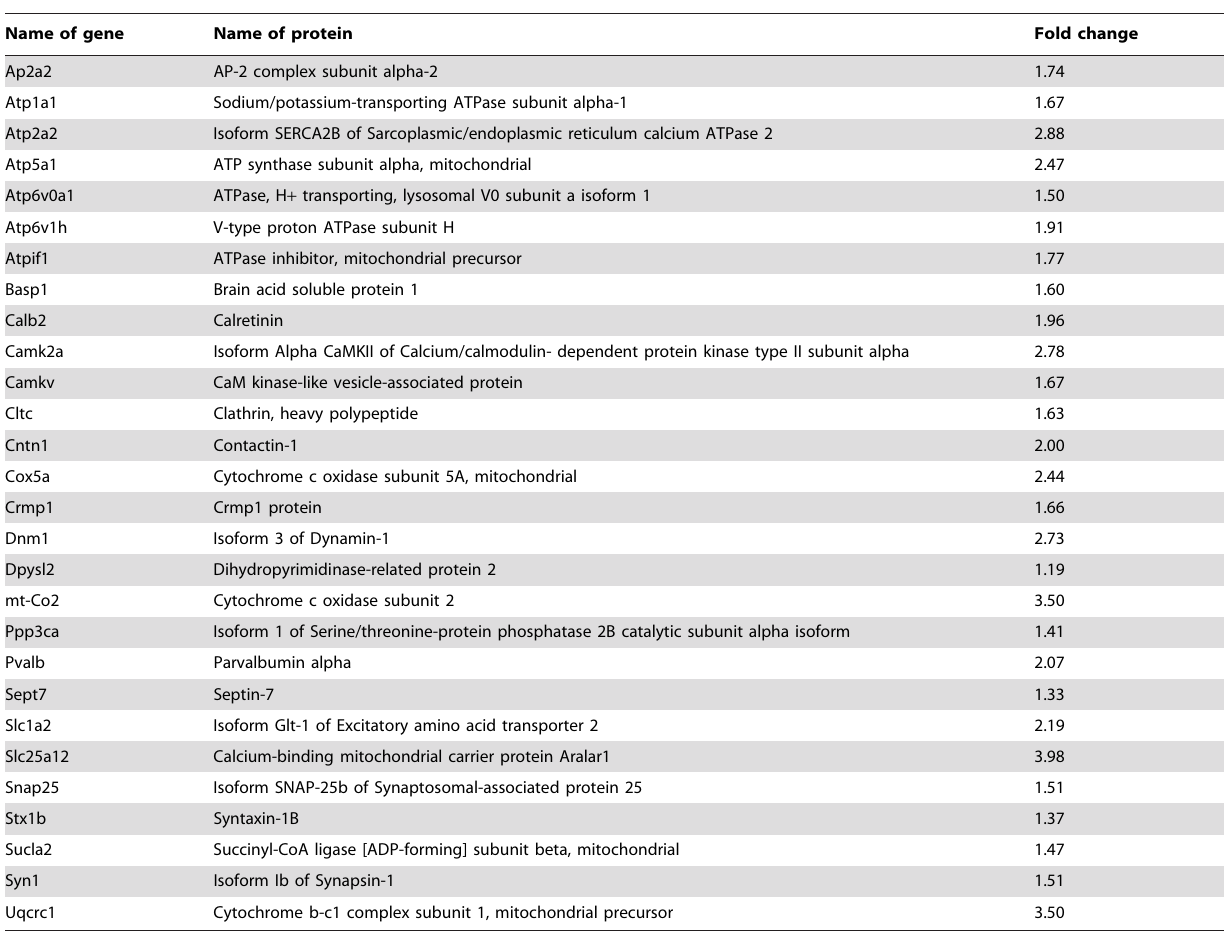
Table 3. Up-regulated proteins due to spaceflight (vs. ground control).